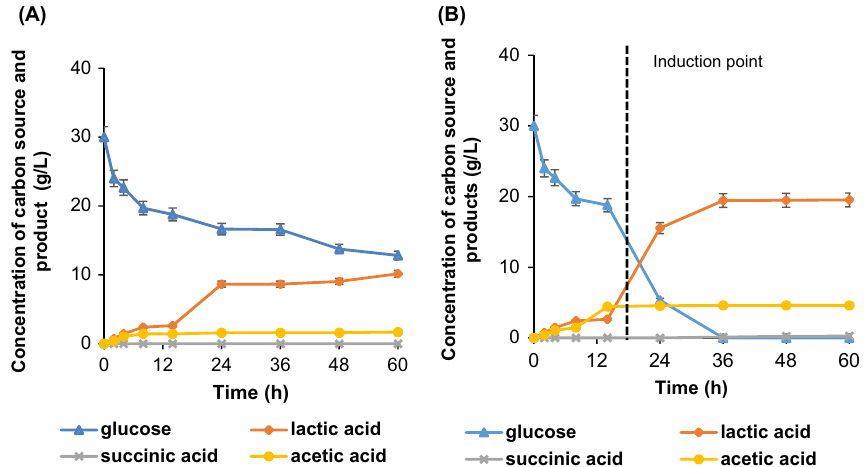
Figure 5. The time-course profile of batch fermentation of lactic acid production by A.succinogenes 130Z in ( A ) mono-phase cultivation ( B ) dual-phase cultivation.